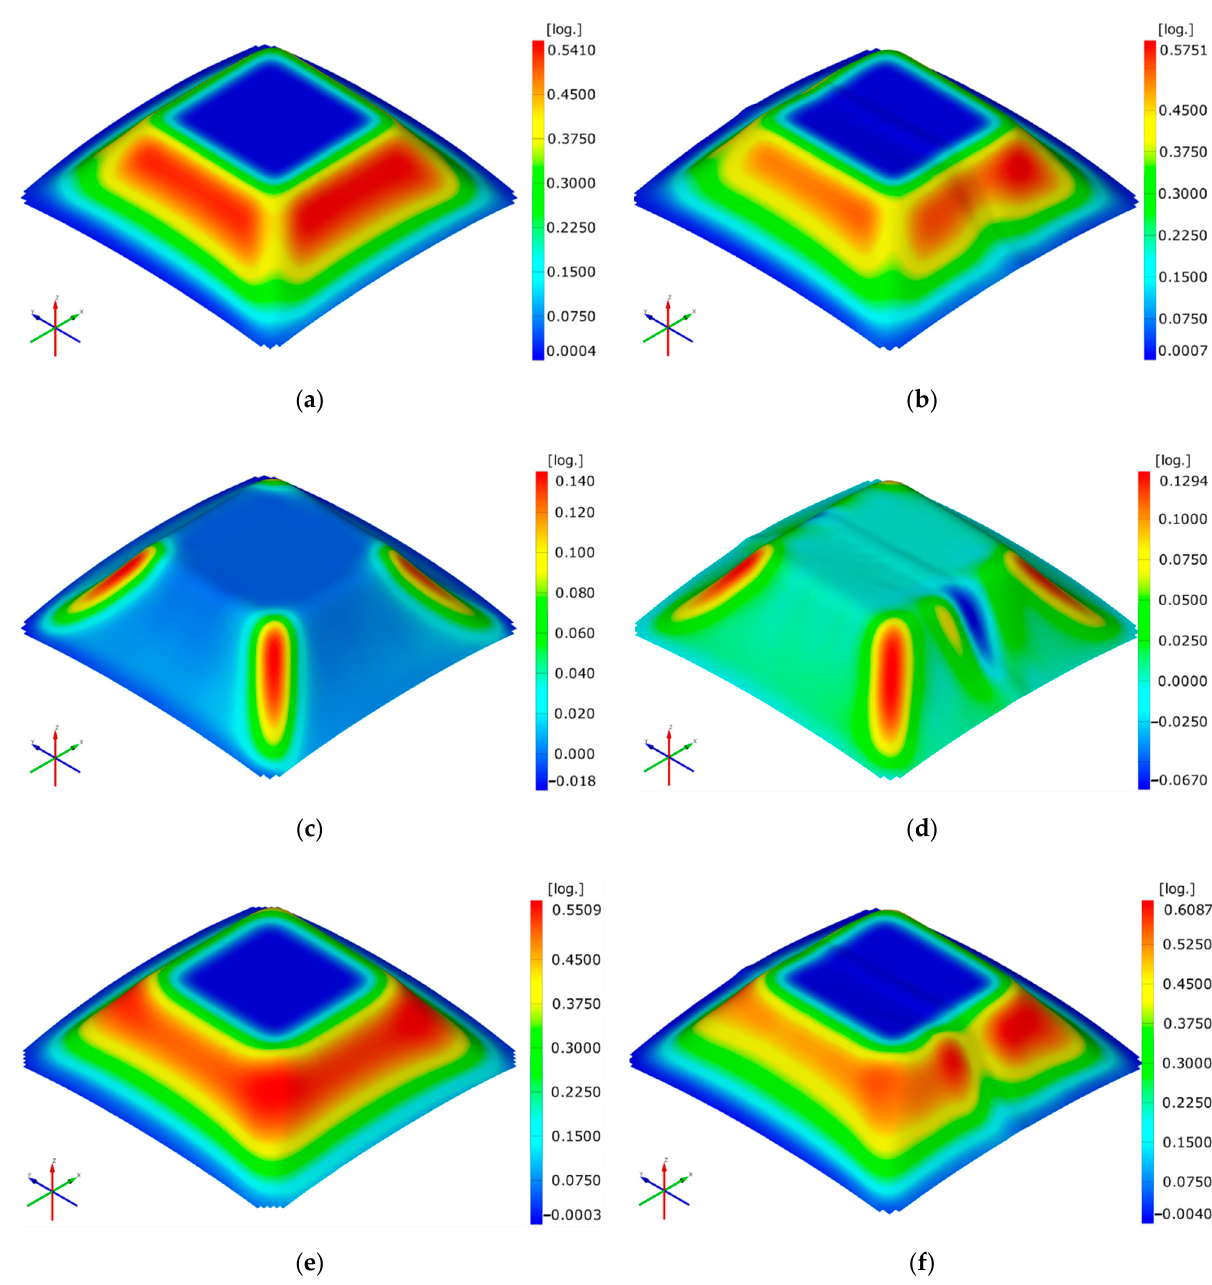
Figure 8. The major strain variation for unwelded blanks ( a ) and double side welded blanks ( b ), the minor strain variation for unwelded blanks ( c ) and double side welded blanks ( d ) and the thickness reduction variation for unwelded blanks ( e ) and double side welded blanks ( f ) for truncated pyramid-shaped parts.